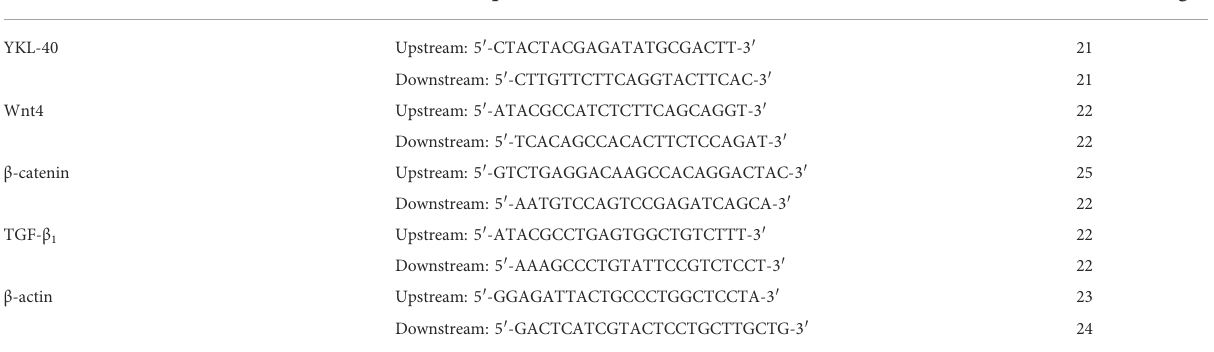
TABLE 1 Genes and their corresponding primer